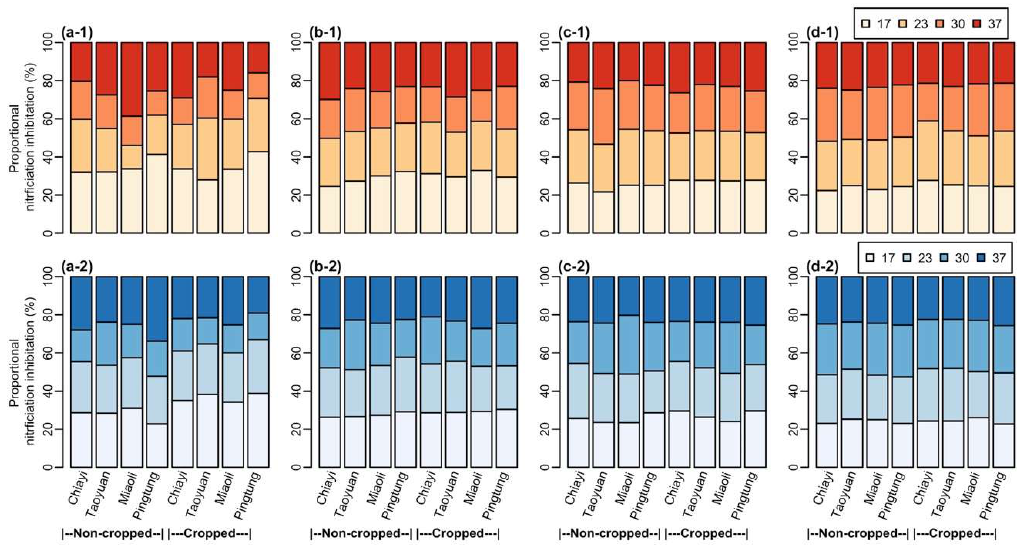
Figure 4. Proportional inhibitory e ff ect expressed as the percentage among four di ff erent temperatures for di ff erent DCD and DMPP treatments. Note: ( a- ), ( b- ), ( c- ), and ( d- ) refer to 0.2 mg kg − 1 , 0.6 mg kg − 1 , 1.2 mg kg − 1 , and 1.8 mg kg − 1 of dry soil, respectively, where 1 refers to DCD and 2 refers to DMPP. Proportional IE was calculated by using mean ( n = 3) values of absolute IE. The standard deviation for each treatment of control, DCD and DMPP, are presented in Figure